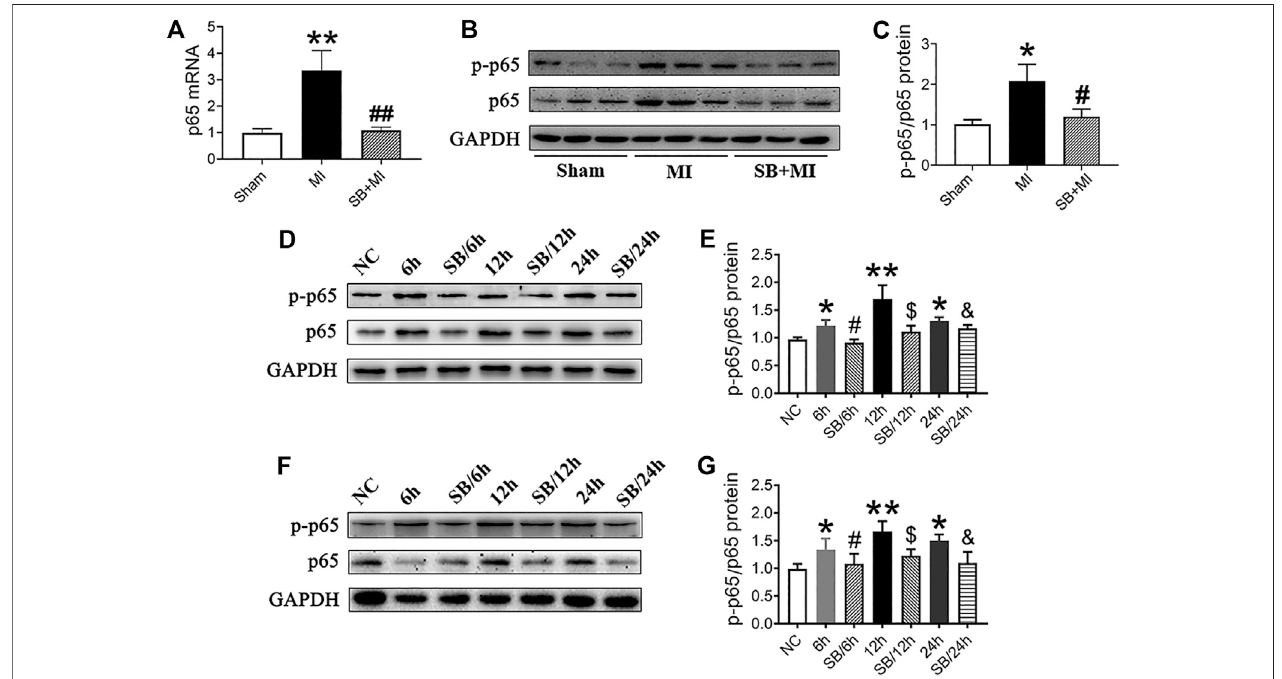
FIGURE 4 | GSK-3 β inhibition downregulates NF- κ B expression in MI tissues, hypoxic cardiomyocytes and H9c2 cells. (A) Real-time fl uorescence quantitative PCR analysis of NF- κ B expression in MI tissues of rats at 7 days ( n (cid:2) 7/group). (B, C) Western blot analysis of p-p65/p65 NF- κ B in MI tissues of rats at 7 days ( n (cid:2) 7/ group).Dataarepresentedasthemean ± SD. ** p < 0.01, < 0.001vs.Shamgroup; # p < 0.05, ## p < 0.01vs.MIgroup. (D – G) Westernblotanalysisofp-p65/p65NF- κ Bin RCMs (D, E) and H9c2 cells (F, G) . Data are presented as the mean ± SD. *p < 0.05, ** p < 0.01 vs. NC; # p < 0.05 vs. 6 h; $ p < 0.05 vs. 12 h; & p < 0.05 vs. 24